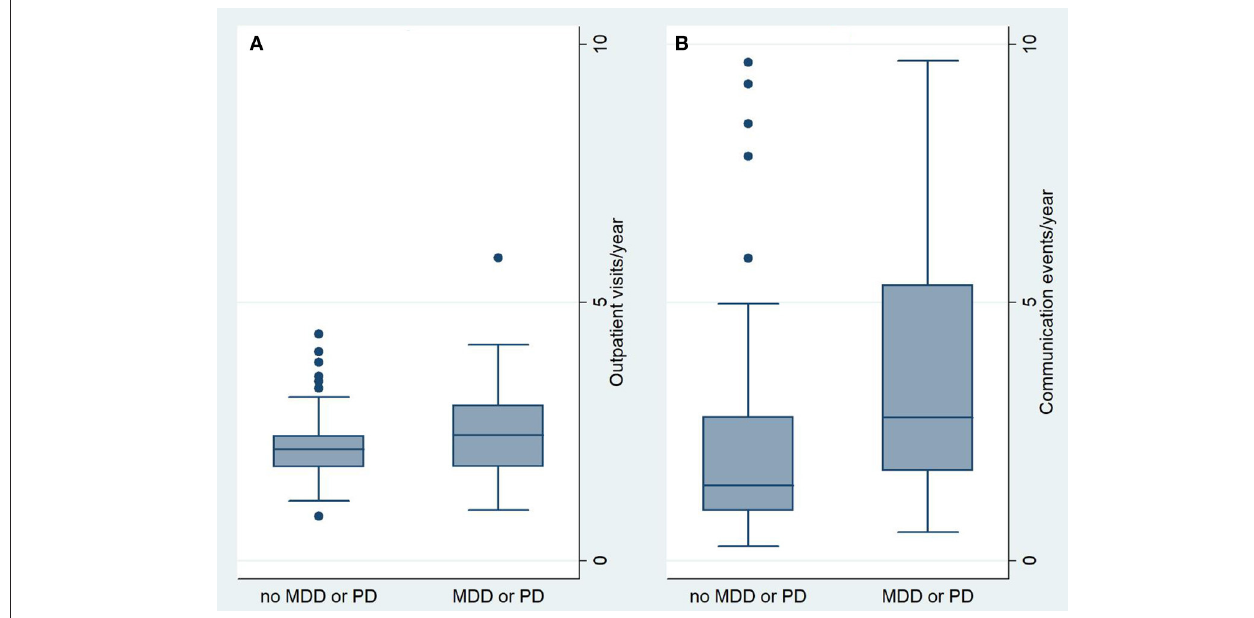
FIGURE 1 | Comparison of Outpatient visits/year (A) and communication events/year (B). MDD, major depressive disorder; PD, panic